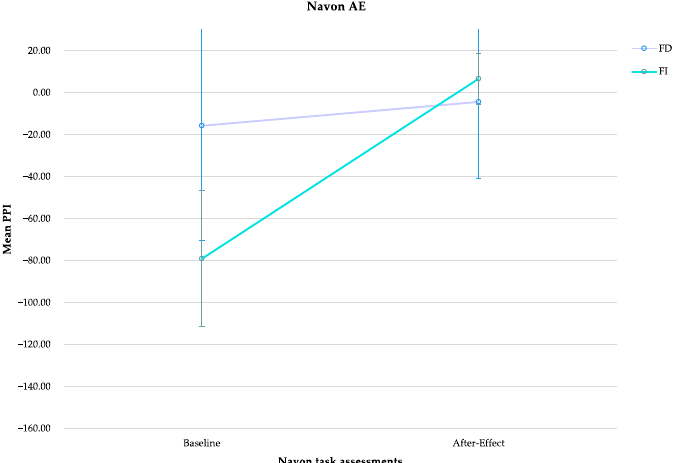
Figure 8. The graphic shows the perceptual preference index (PPI) scores ( ± SE) for field dependent (FD) and field independent (FI) in both baseline and after-effect assessments of the Navon task.